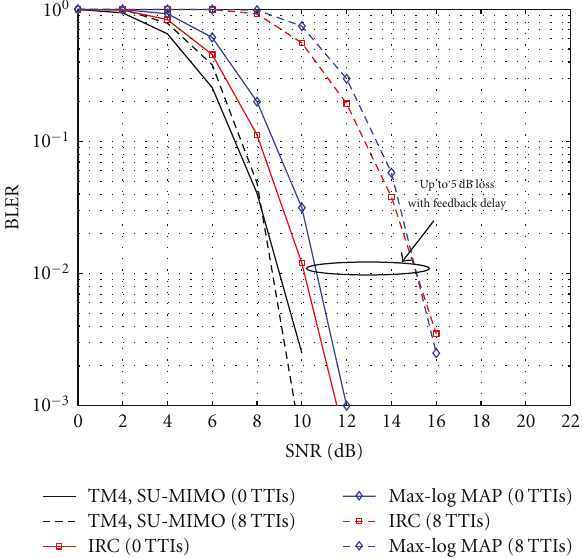
Figure 6: BLER versus SNR (dB) performance of MU-MIMO receivers for 16QAM modulation, urban macro, 30km/h, LS- channel estimation, and feedback delay.